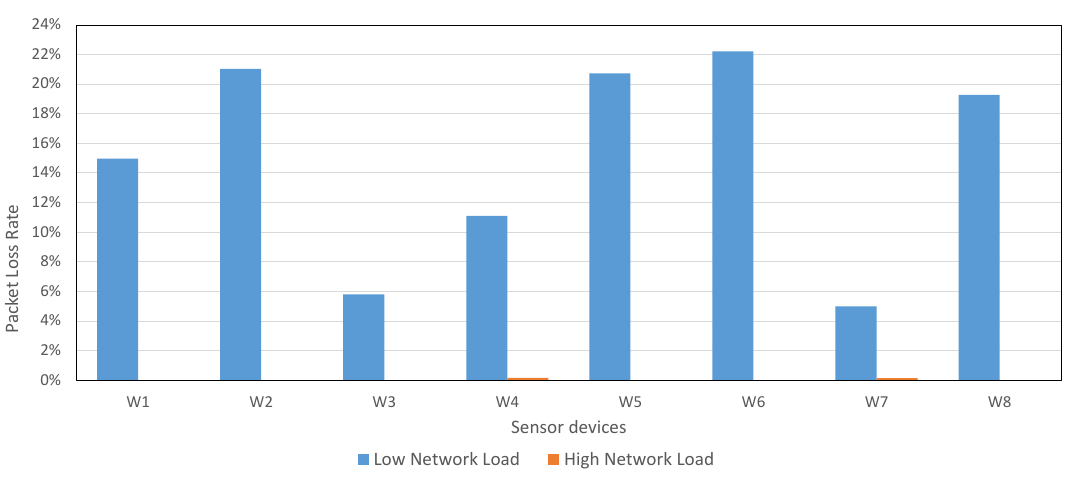
Figure 18. PLR in Collaborative Mesh for 8 sensor devices and 3 CSR devices with saving mode configuration.